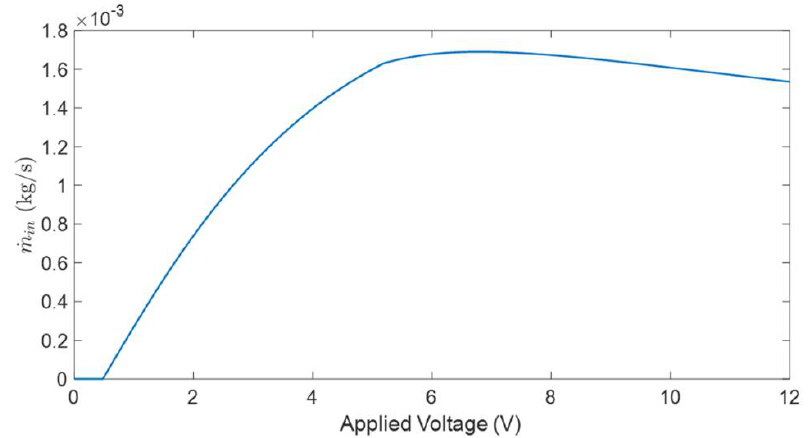
Figure 7. Mass flow rate in the valve versus the applied voltage.